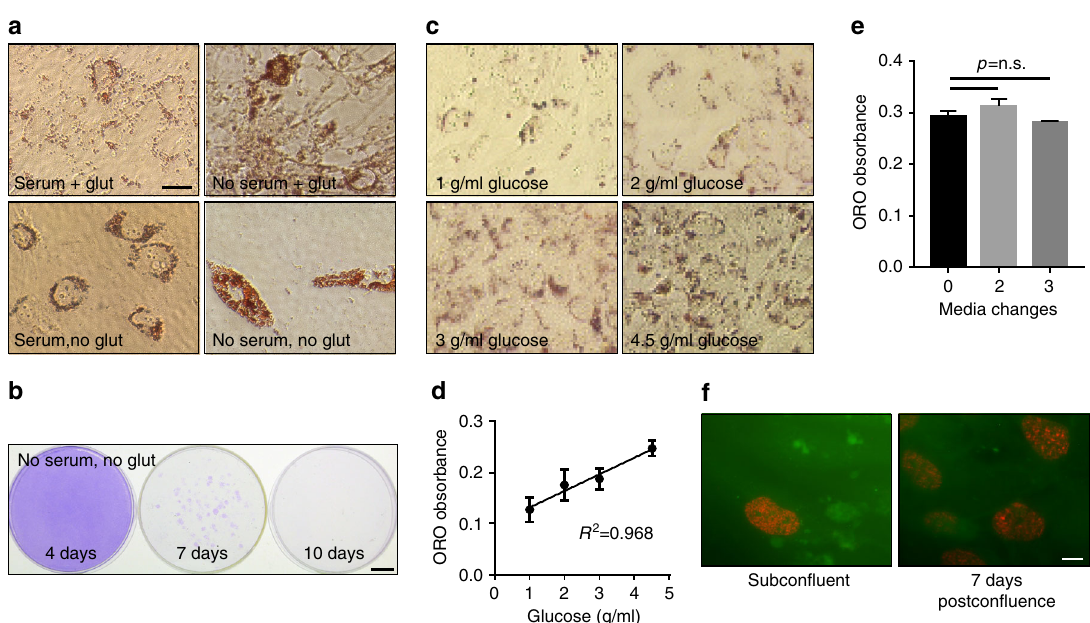
Fig. 2 Lipid accumulation is dependent on glucose, but independent of glutamine. a Photomicrographs of Oil Red O-stained 786-O cells cultured in the presence or absence of serum and glutamine, as indicated. Bar = 10 μ m. b Crystal violet staining of rescued cells from treatment as in a . Bar = 1 cm. c Photomicrographs of Oil Red O-stained 786-O cells cultured in indicated glucose concentrations. d Quanti fi cation of Oil Red O of cells in c and graphed versus glucose concentration. Square of the Pearson correlation coef fi cient r is shown. e Quanti fi cation of Oil Red O of 786-O cells with media changes 0, 2, or 3 times during the 7-day period. f Fluorescent labeling of BrdU incorporation of 786-O cells at subcon fl uent or at 7 days post con fl uence. Bar = 10 μ m. p values of two-tailed Student ’ s t tests are displayed. Error bars represent standard